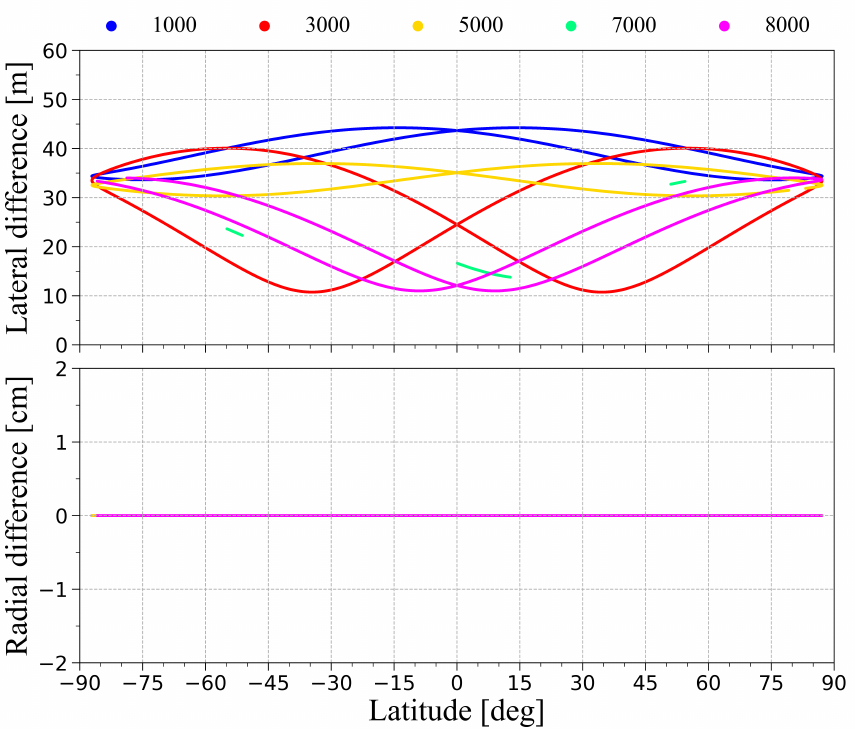
Figure 8. Lateral ( top ) and radial ( bottom ) differences between the footprint geolocations using the IAU1991 and IAU2000 Mars rotational